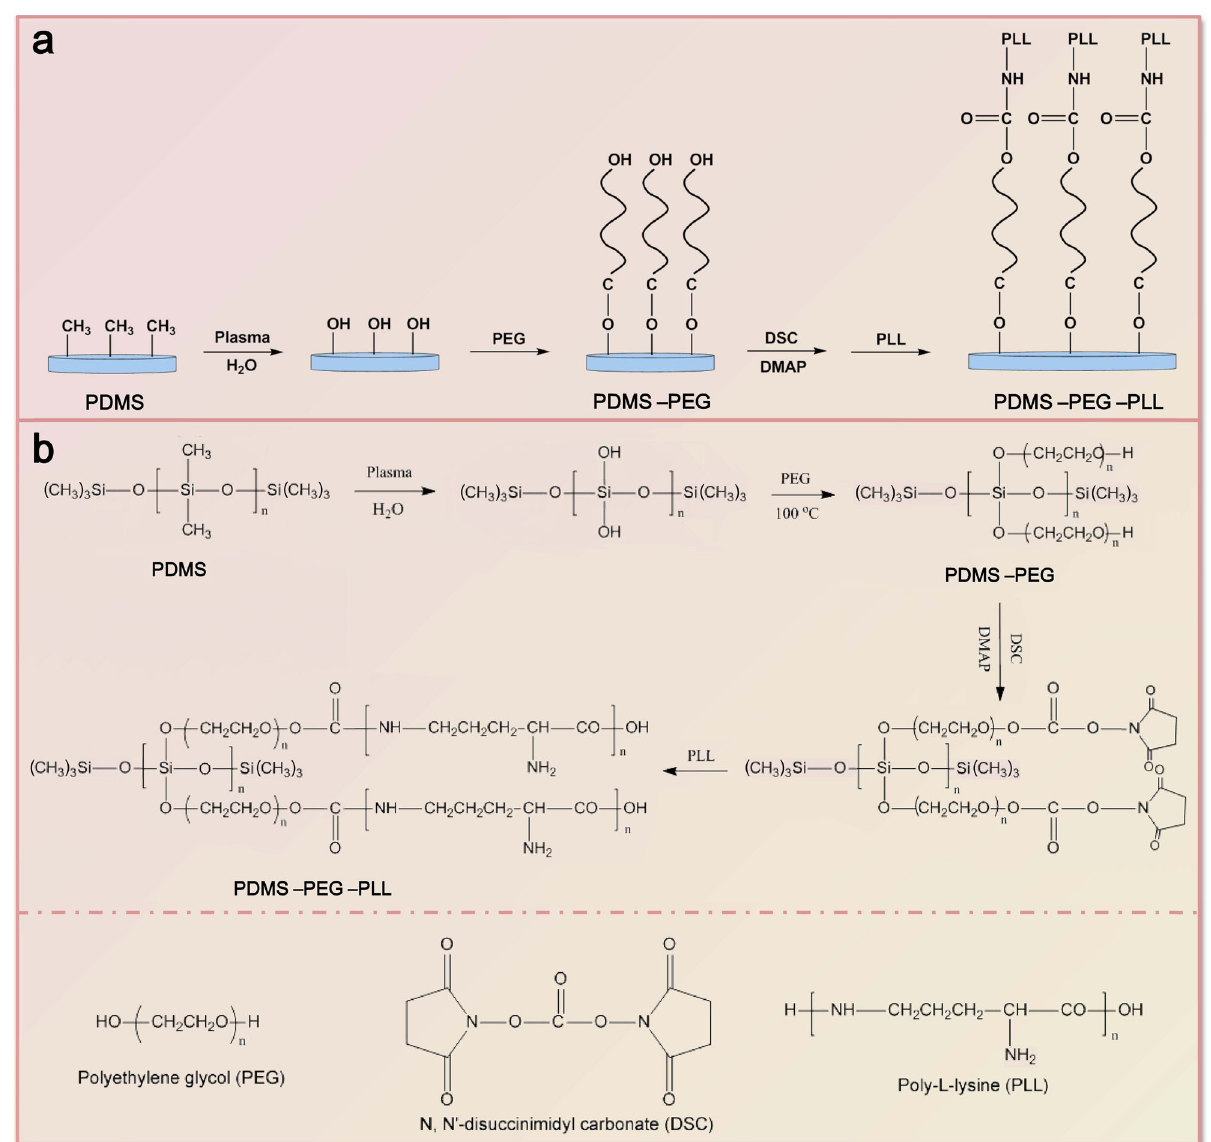
Fig. 1 a Schematic diagram and b reaction process of surface-modi fi ed strategy to PDMS by chemically coupling PEG and